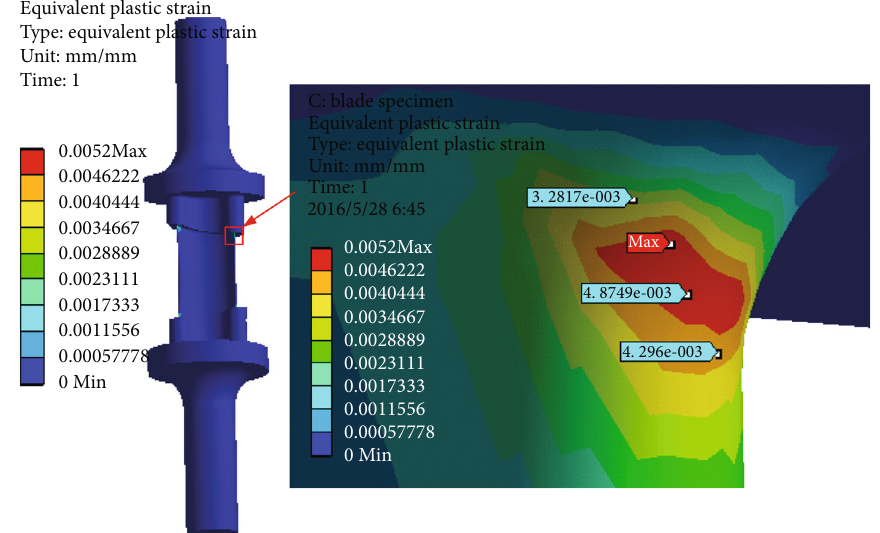
Figure 18: Equivalent plastic strains of the specimen.